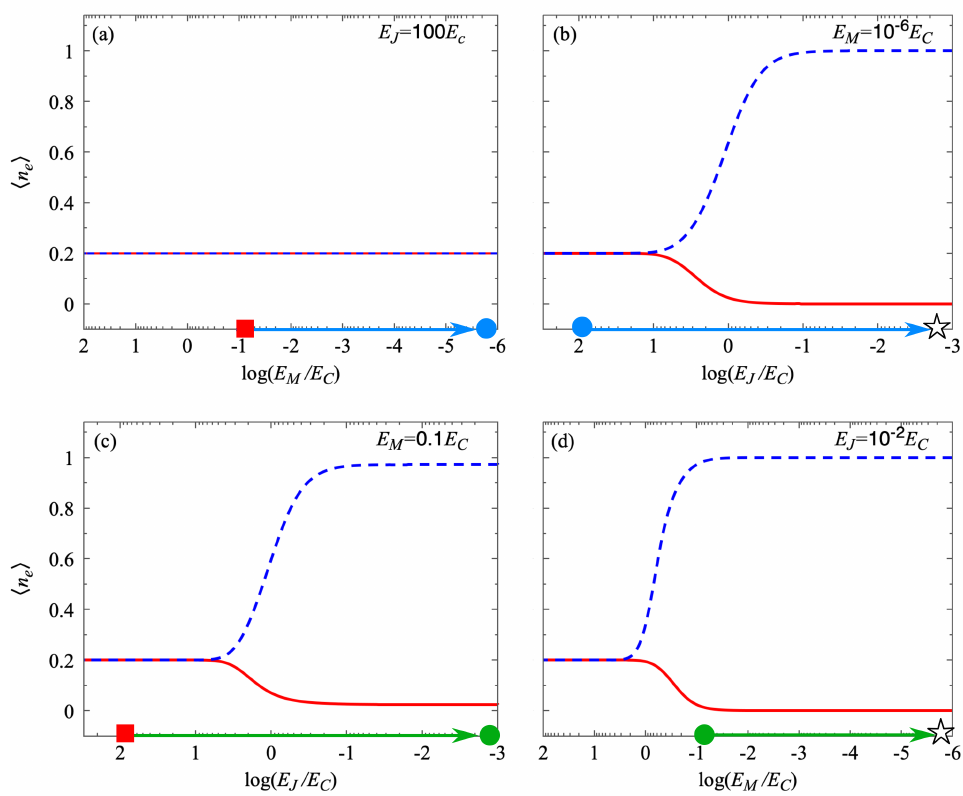
Figure 6: Average charge in island for the system ground (solid red line) and first excited state (dashed blue line). Panels (a) and (b) relate to the fusion protocol, while (c) and (d) relate to the reference protocol. The remaining parameters are the same as in Fig.